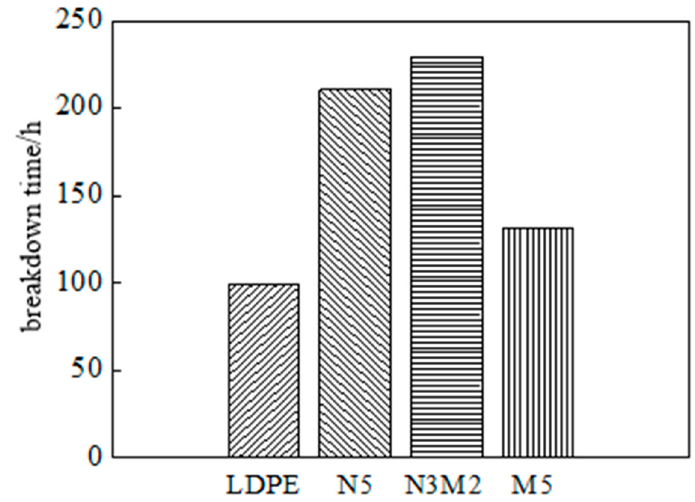
Figure 10. Breakdown time of corona for LDPE and ZnO/LDPE samples.